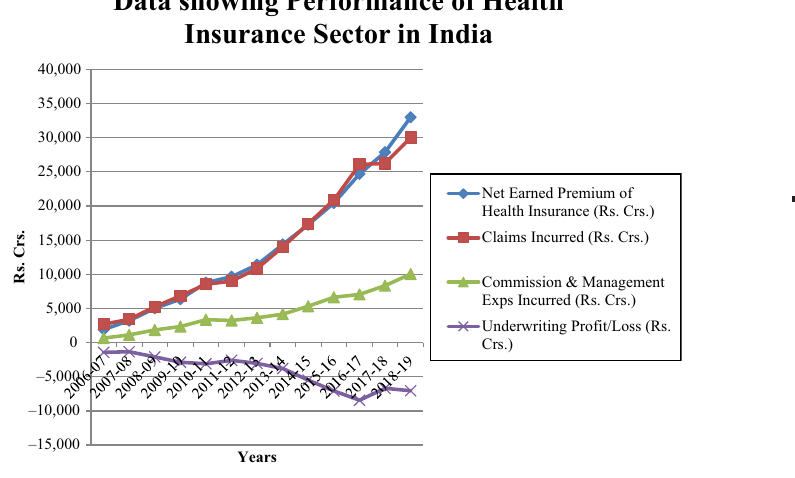
Figure 2. Chart on performance of health insurance sector in